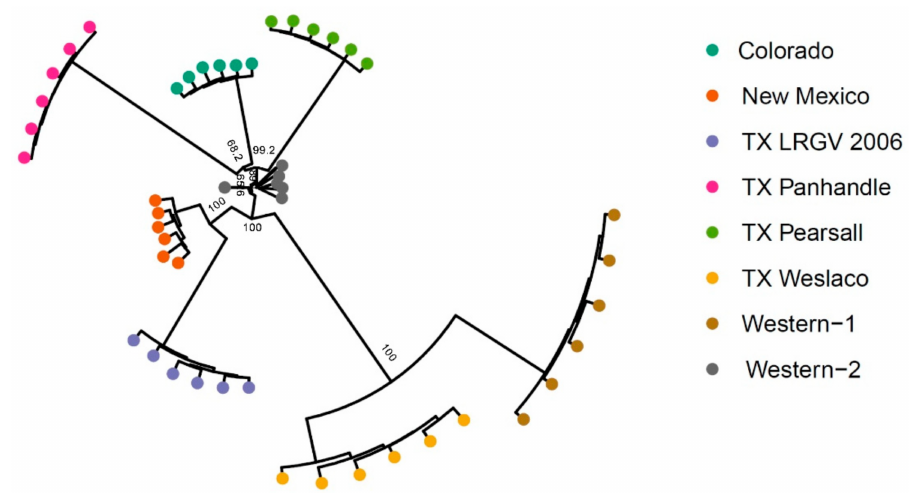
Figure 5. Neighbor-joining tree of 48 samples from eight populations. Five hundred bootstrapping resampling was conducted to obtain the support values indicated at the branch. Support values are not labeled for the end branch because the eight samples within a population are rather similar, given they were pooled